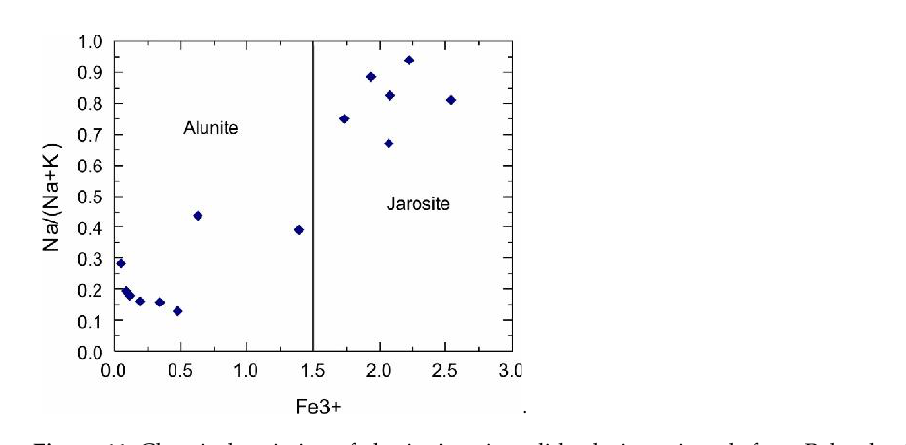
Figure 11. Chemical variation of alunite‐jarosite solid solution minerals from Paleochori vents as a function of Na/(Na + K) relative to Fe 3+